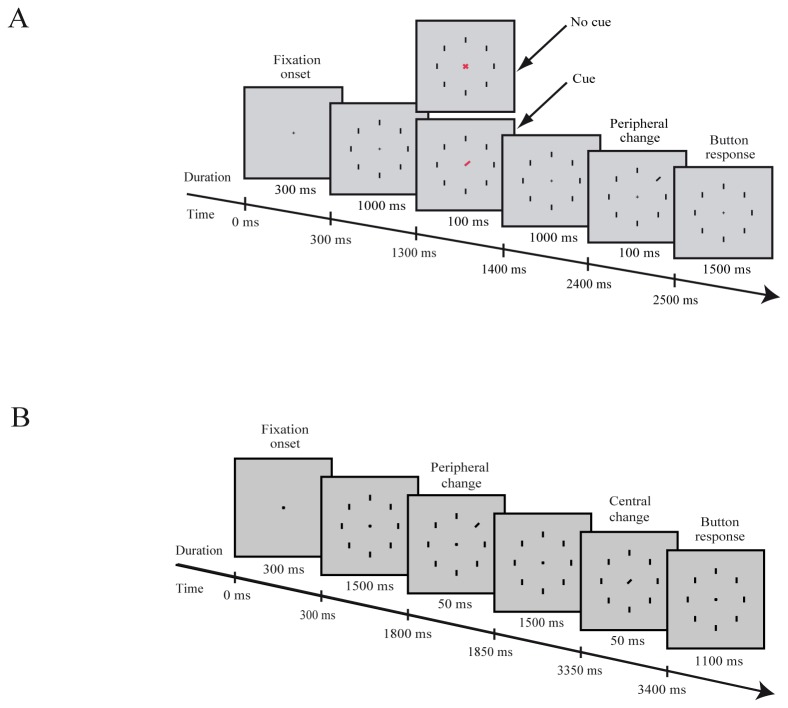
Illustration of the tasks.
A: The cue/no-cue task. B The matching task. Time is from fixation onset.